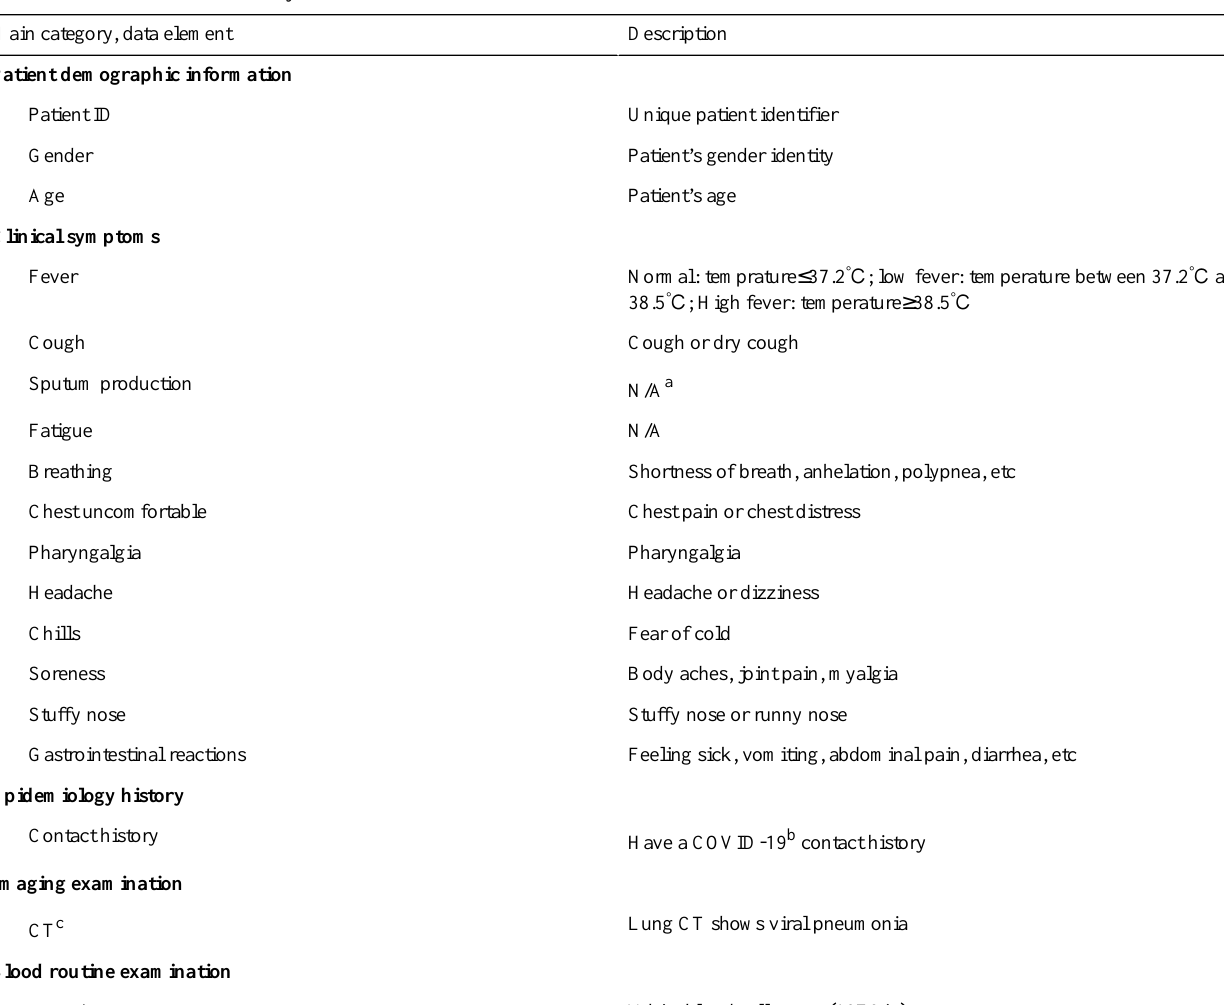
Table 1. The data elements in the dynamic risk stratification